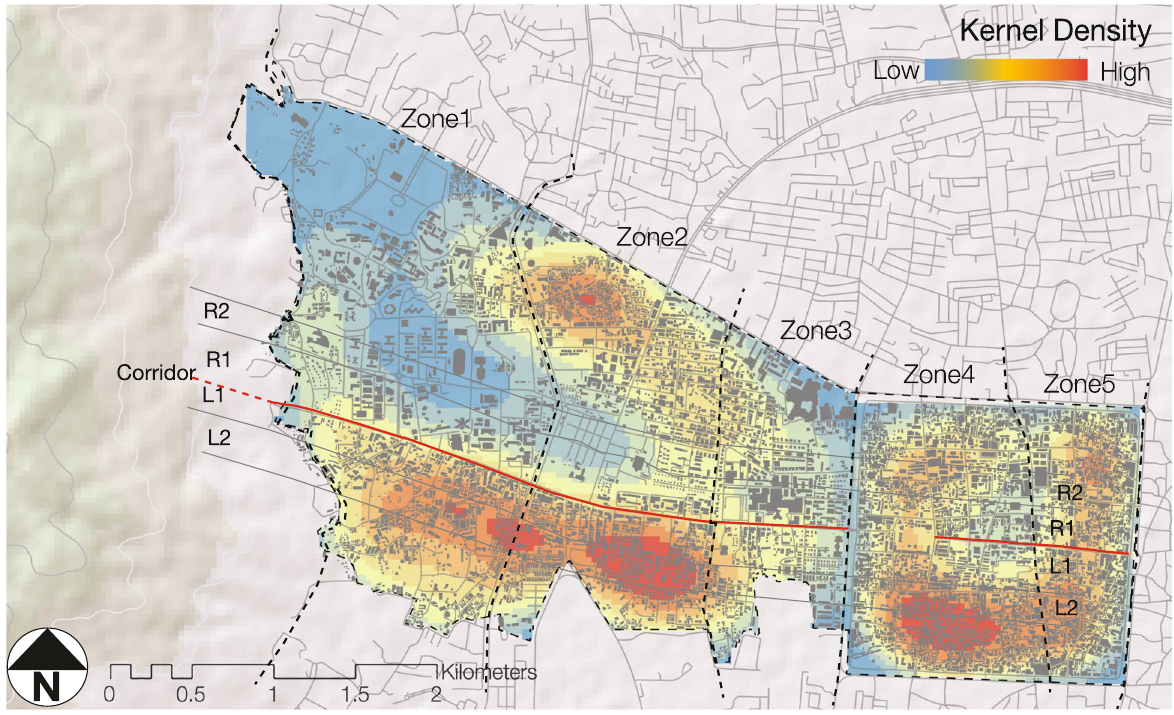
Fig. 7 Building density in five zones (Source: the